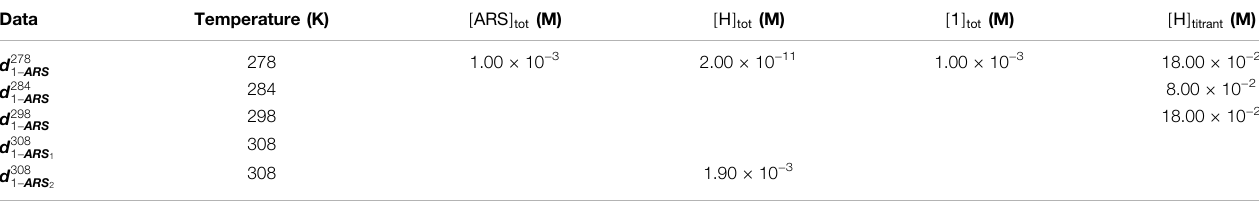
TABLE 5 | Conditions of the simulated datasets related to ARS and 1 titration with a strong acid. Data